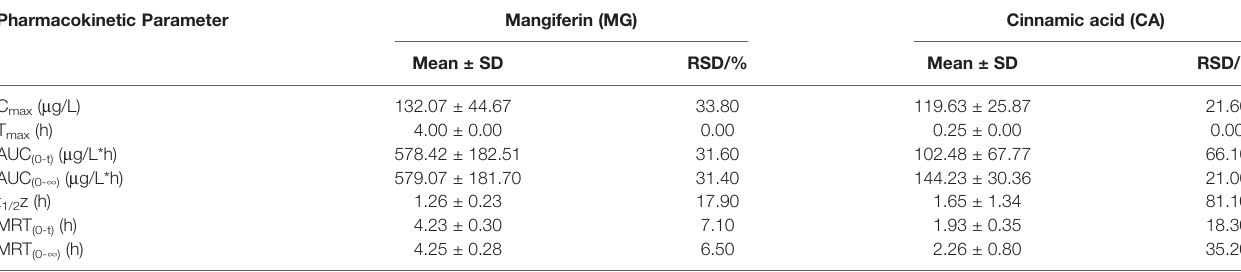
TABLE 2 | Pharmacokinetic parameters analyzed by the UHPLC-QTRAP-MS/MS system. Pharmacokinetic